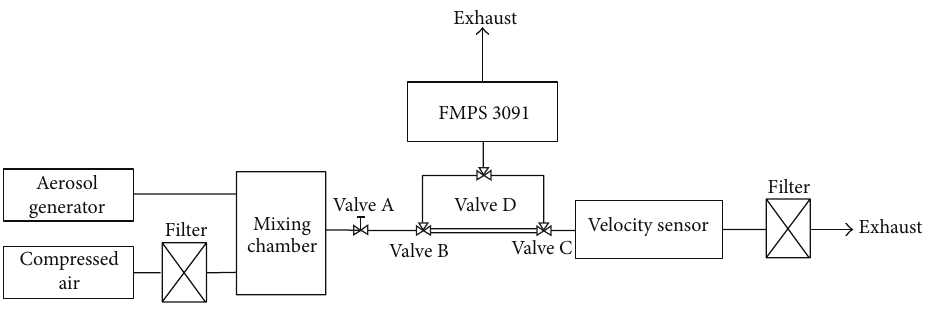
Figure 1: A sketch of the experimental